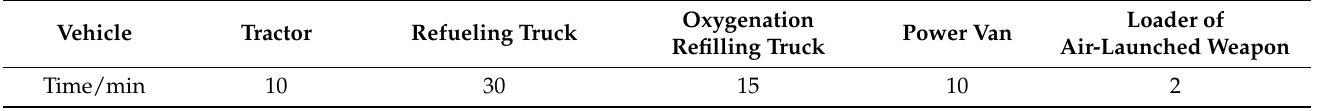
Table 3. Average operating time of each support vehicles.